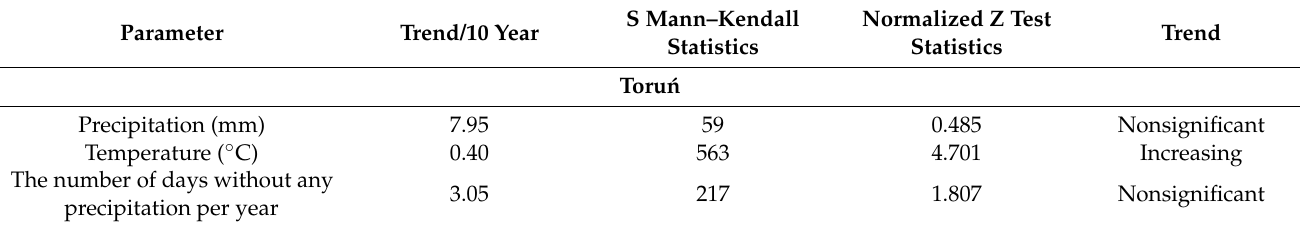
Table 4. Statistical analysis of the meteorological data in Toru´n for